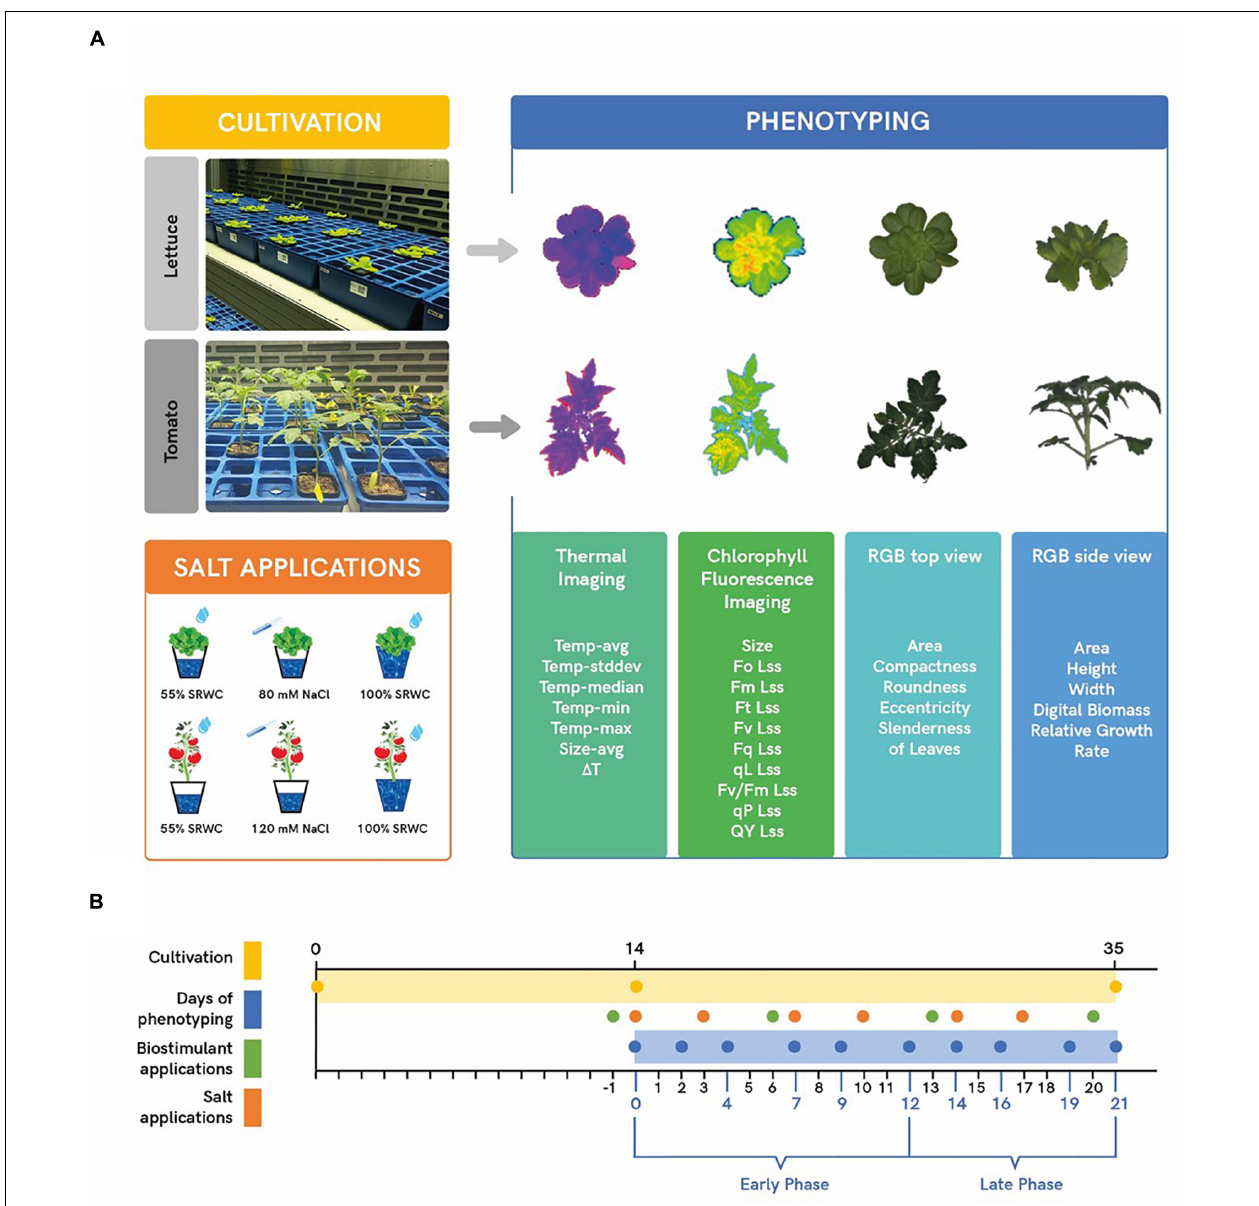
FIGURE 1 | Scheme of plant cultivation and phenotyping protocol. Plants were manually transferred from the cultivation chamber to PlantScreenTM Compact System for imaging using four different sensors (thermal camera, chlorophyll fluorescence, and top and side RGB). The resulting false-color, segmented images, and list of extracted parameters obtained from the sensors are shown (A) . Timeline of plant cultivation (yellow bar) and phenotyping protocol (blue bar). Green dots show four-time points of the foliar application for the selected biostimulants and the orange dots show six timepoints for the salt treatment (B)